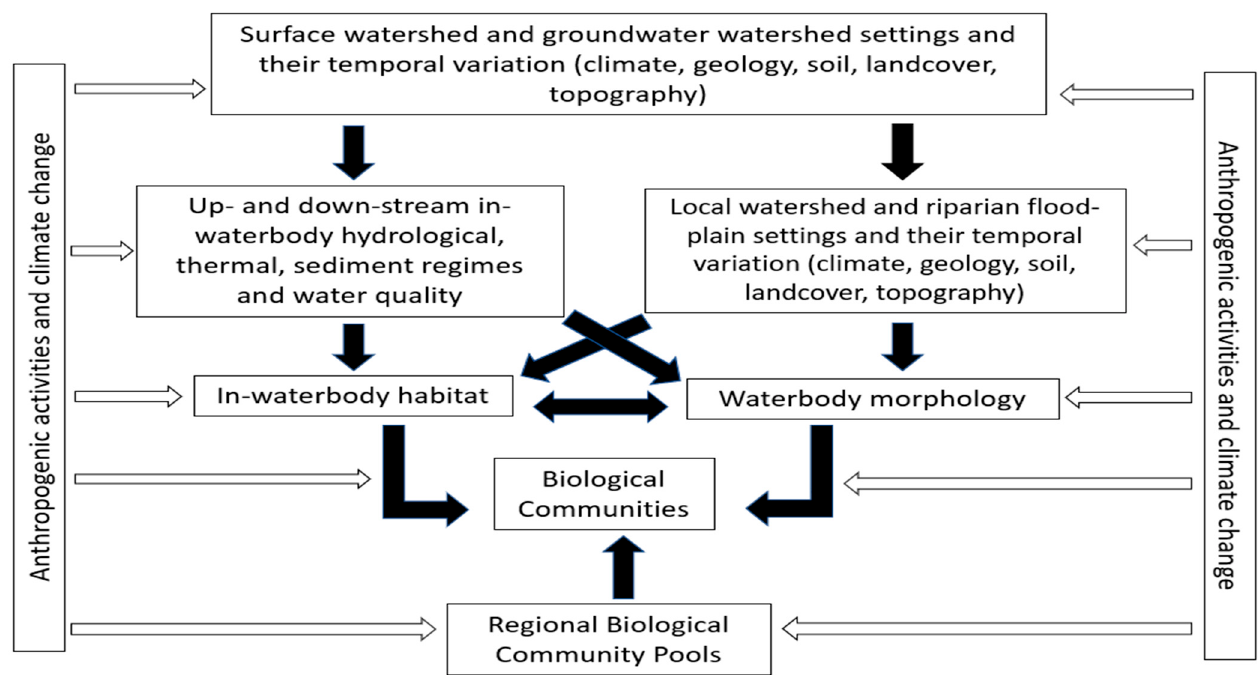
Figure 1. Conceptual linkages of landscape factors at multiple spatial scales and their influence on freshwater systems.